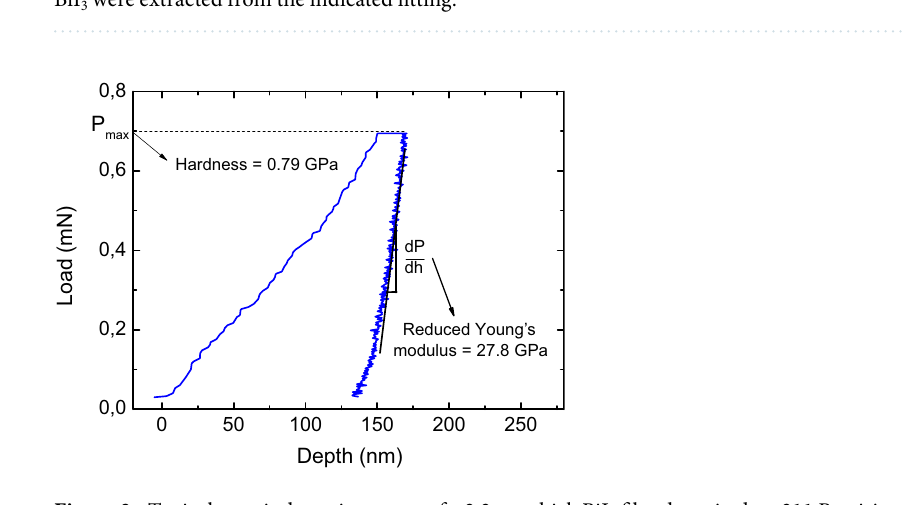
Figure 3. Typical nanoindentation curve of a 2.2 μ m-thick BiI 3 film deposited on 211 Precision